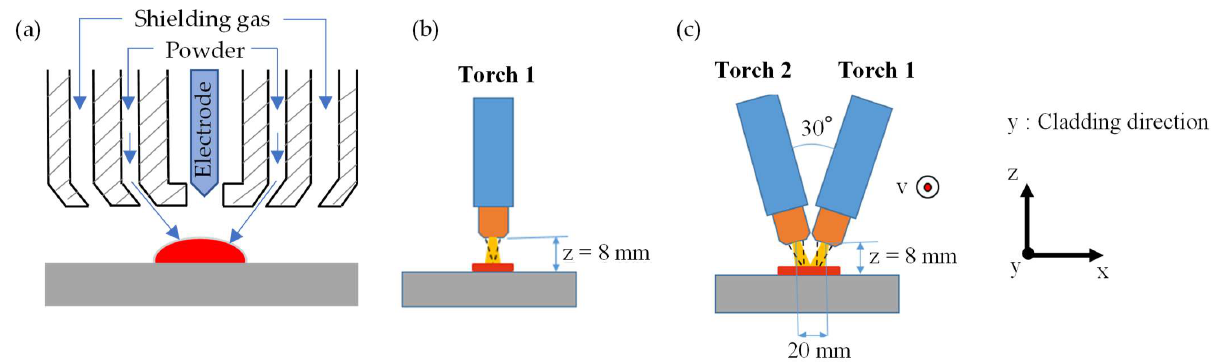
Figure 1. ( a ) Cross-section of torch conventional PTA ( b ) and tandem PTA ( c )